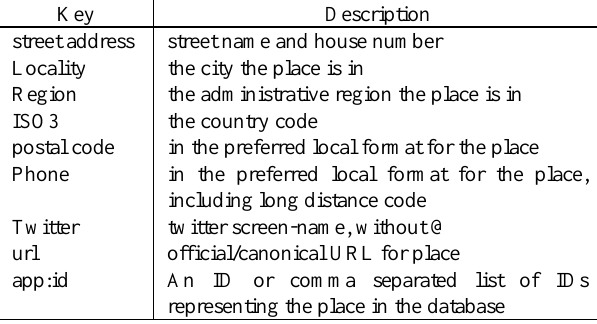
Table 1. Attributes used by FourSquare to describe a